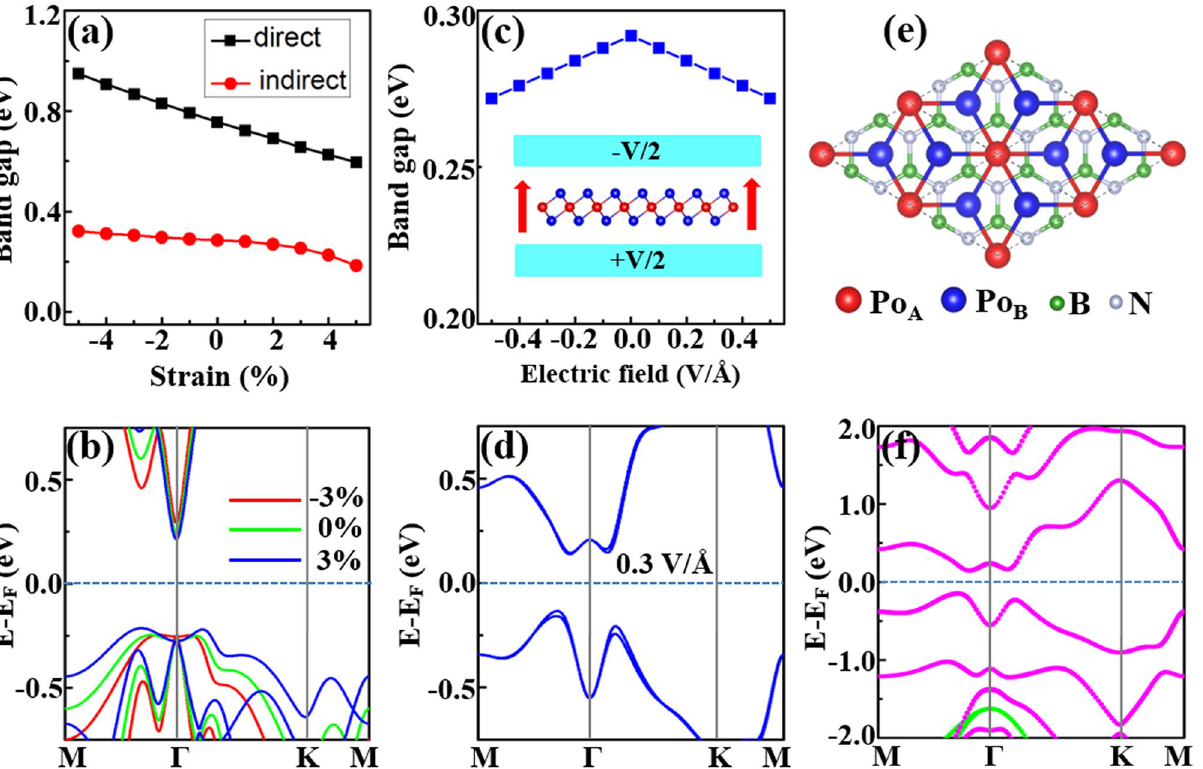
Figure 6. ( a ) Direct and indirect band gaps of the trigonal poloniumene as a function of the in-plane biaxial strain. ( b ) Band structures without SOC under the different strains. ( c ) Global band gaps of the trigonal poloniumene as a function of the external electric field. The inset shows the schematic diagram of the material with an external electric field. ( d ) Band structure of the poloniumene with SOC under the electric field of 0.3 V/Å. ( e ) Top view of the trigonal poloniumene on an h -BN substrate. ( f ) Band structure of the trigonal poloniumene/ h -BN heterostructure with SOC. The magenta and green bands are contributed by the states from the trigonal poloniumene and the h -BN substrate,